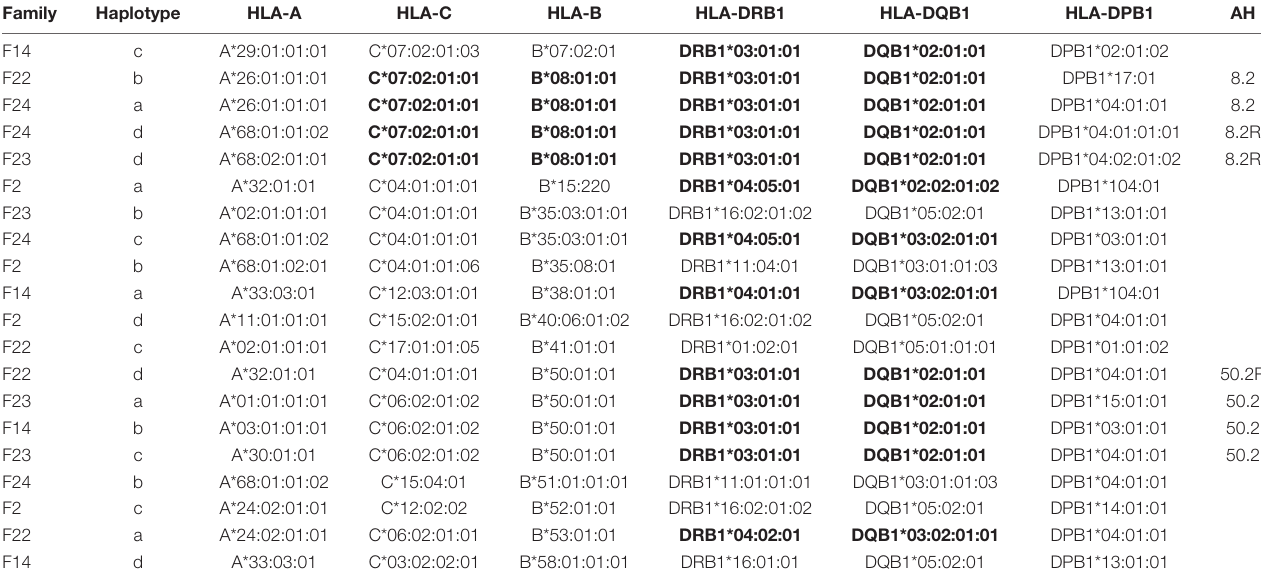
TABLE 2 | Segregation analysis of HLA haplotypes from 5 families reveals the presence of extended haplotypes in different and apparently unrelated families. Family